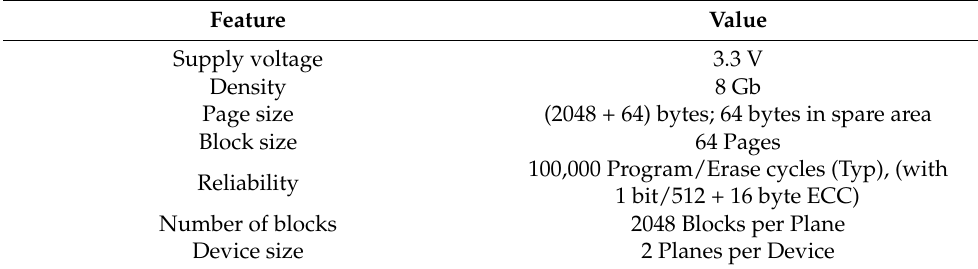
Table 2. S34ML08G1 NAND flash memory feature summary.